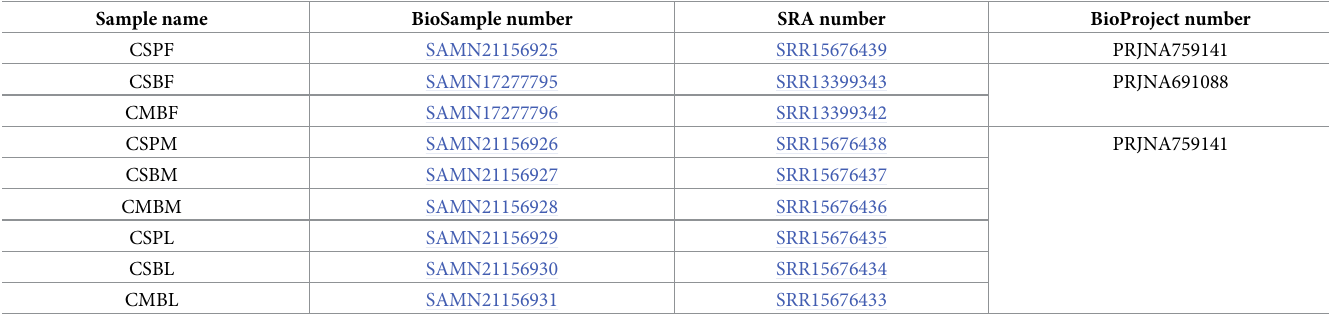
Table 2. Properties of the selected